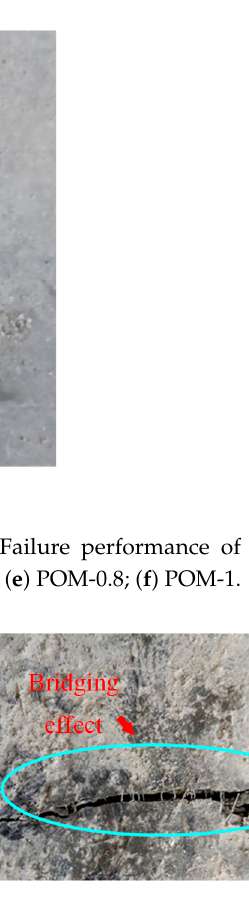
Figure 21. Bridging effect in the POM-0.8-3 splitting tensile test specimen.